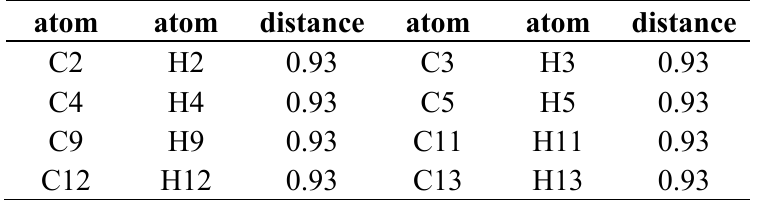
Table 5. Bond lengths involving hydrogen's (Å) for compound 4a